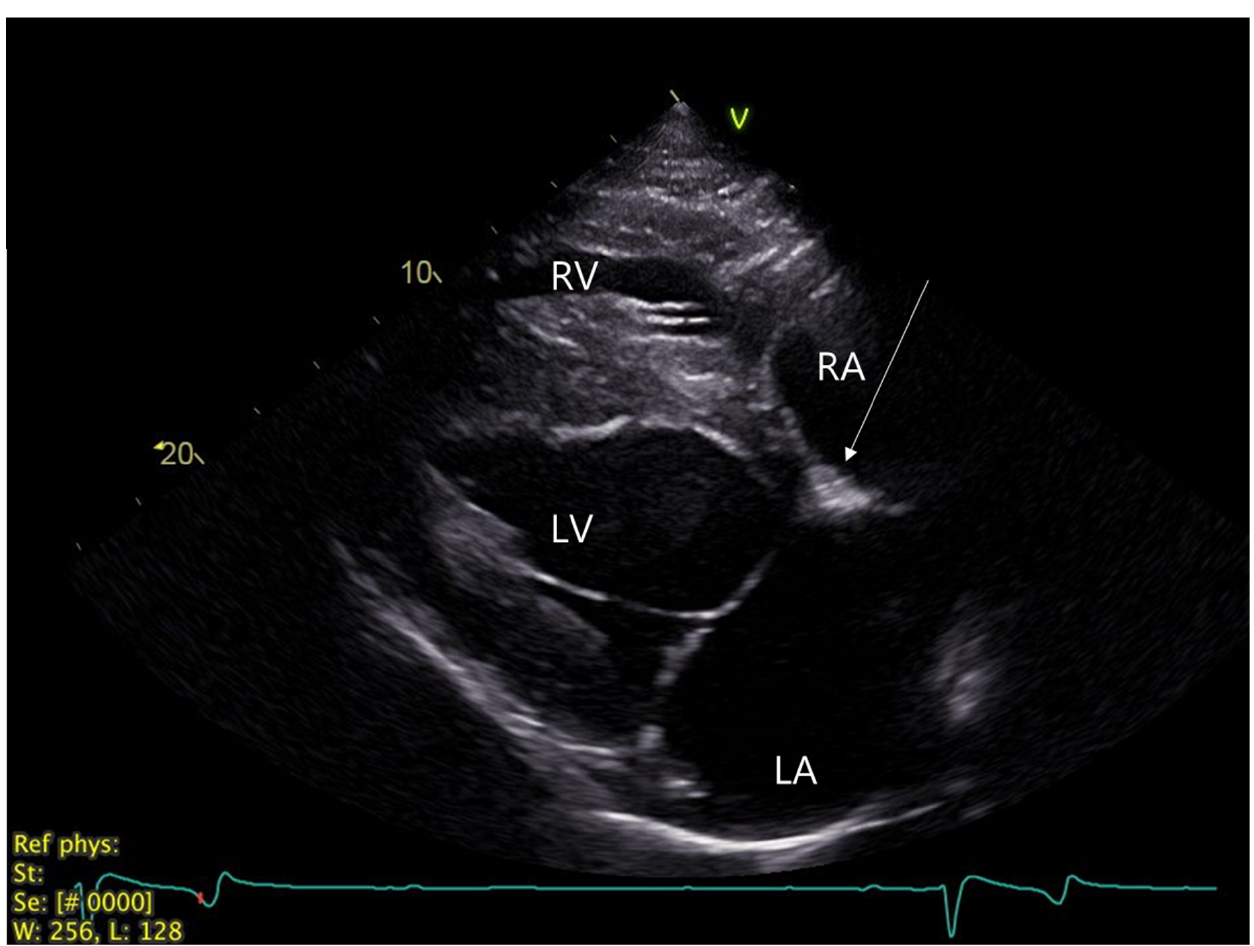
Figure 2. Echocardiogram. Right parasternal, long-axis, four-chamber view of the heart with focus on left atrium. Arrow highlights hyperechogenic zone in the proximal interventricular region (AV nodal area). AV: Atrioventricular, LA: Left atrium, LV: Left ventricle, RA: Right atrium, RV: Right ventricle.